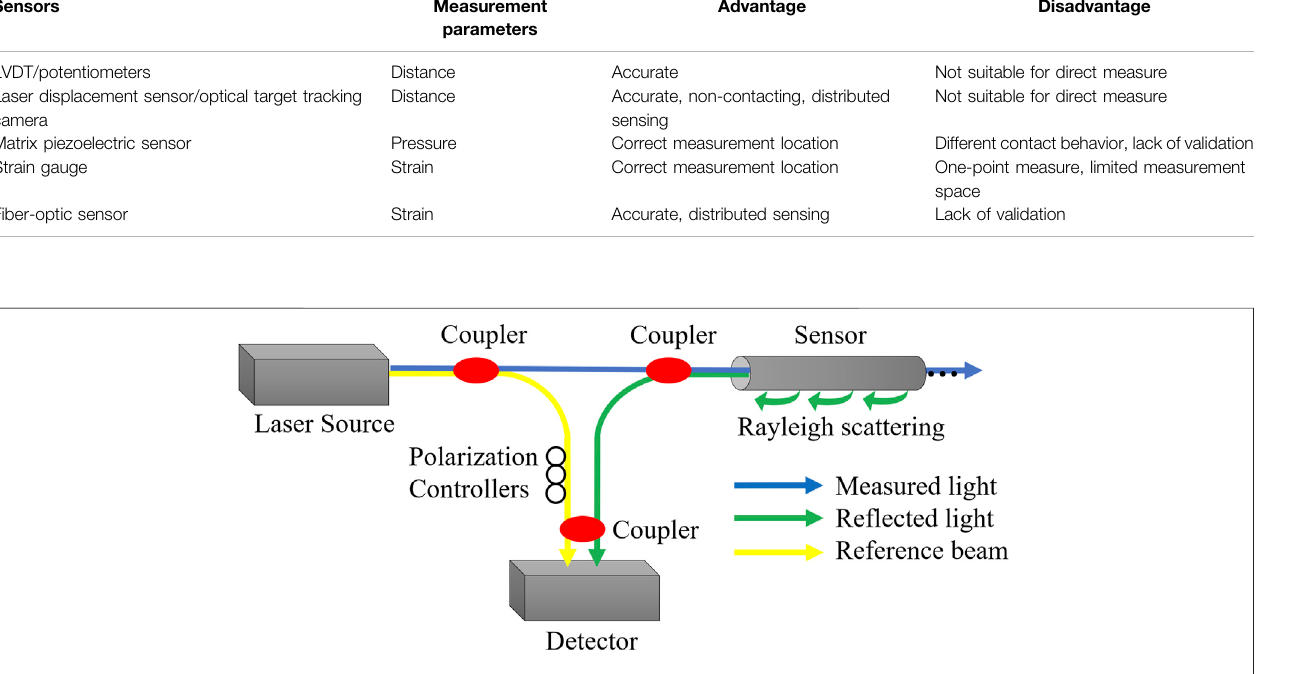
FIGURE 4 | Principle of